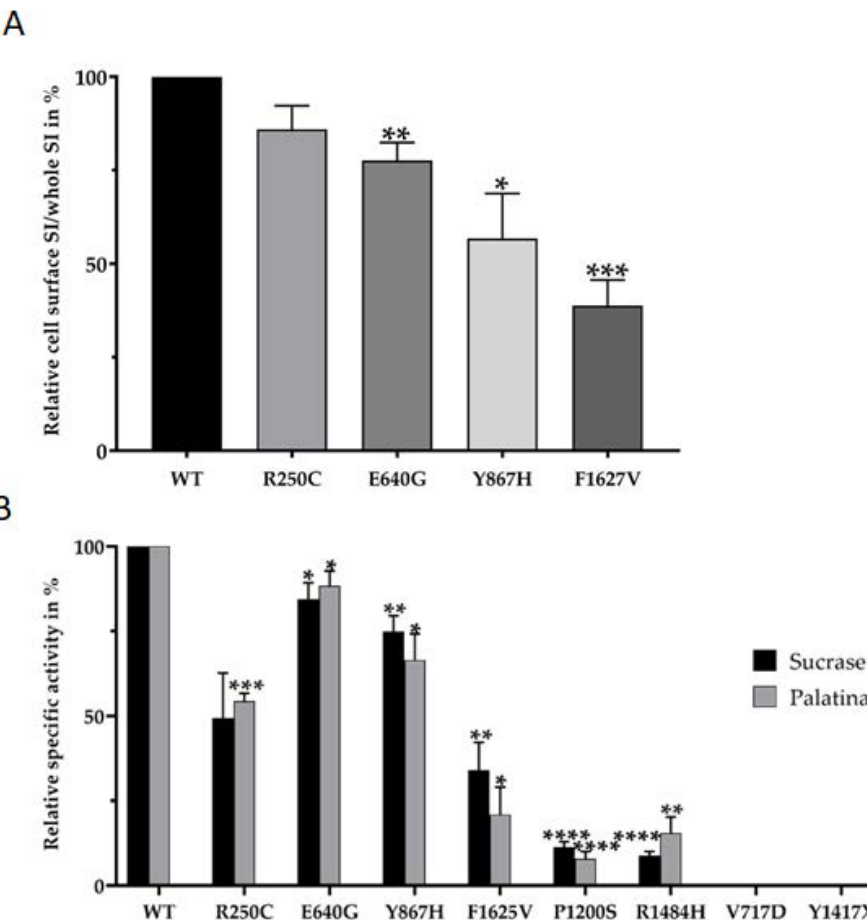
Figure 3. ( A ) Cell surface expression of the SI mutants. SI mutants were expressed in COS-1 cells Table 100. (Unpaired t -test, * p < 0.05, ** p < 0.005 and *** p < 0.0005, S.E.M., n ≥ 3). ( B ) Relative Specific enzyme activities of the SI mutants. SI-WT or SI mutants were expressed in COS-1 cells and immunoprecipitated by mAb anti-SI. The immunopre- cipitates were assayed for enzymatic activity using sucrose or palatinose as substrates. Similar samples were analyzed by Western blotting and the protein band intensity was used to quantify the specific activities of the SI proteins. Relative specific activities are measured in comparison to wild type SI that was set to 100% for sucrase or palatinase. (Paired t -test, * p < 0.05, ** p < 0.005, *** p < 0.0005 and **** p < 0.00005 S.E.M., n ≥